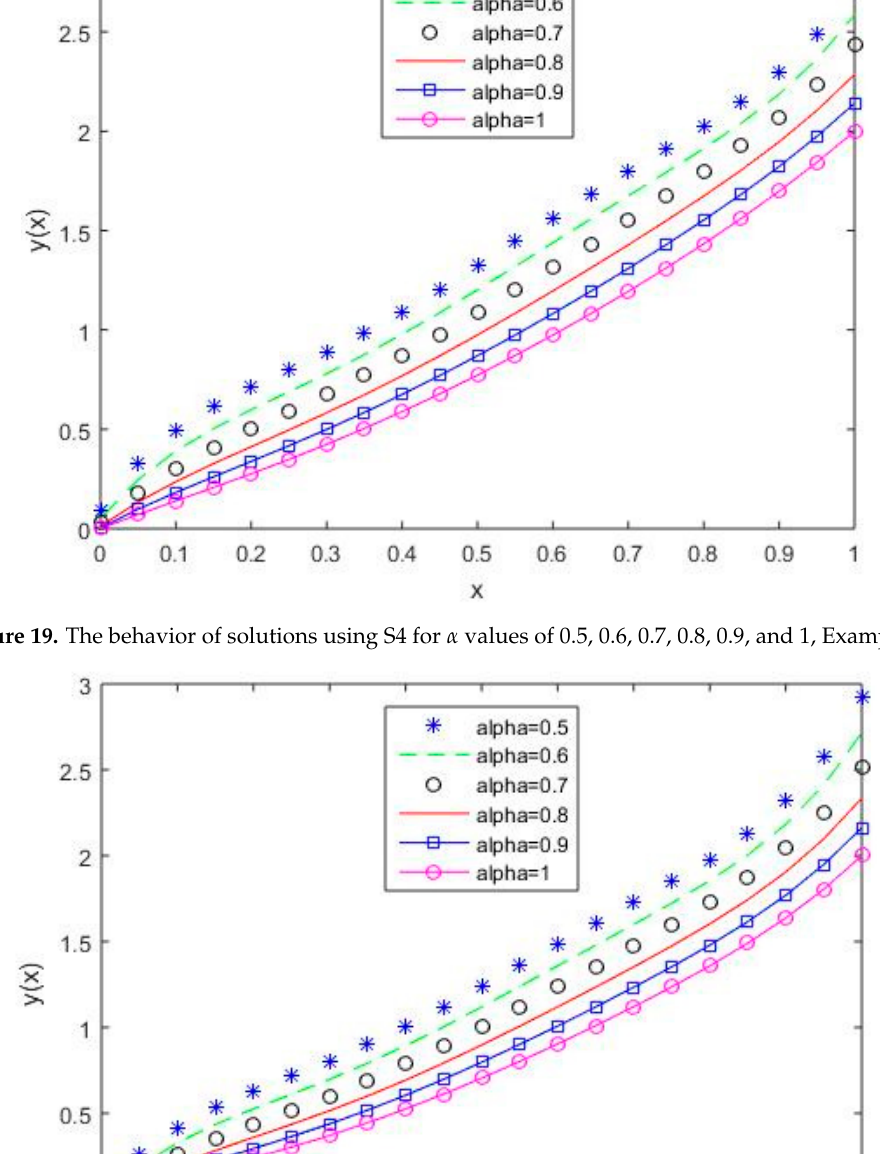
Table 2. Result comparison of Example 2 for different orthogonal polynomials at different values of n .